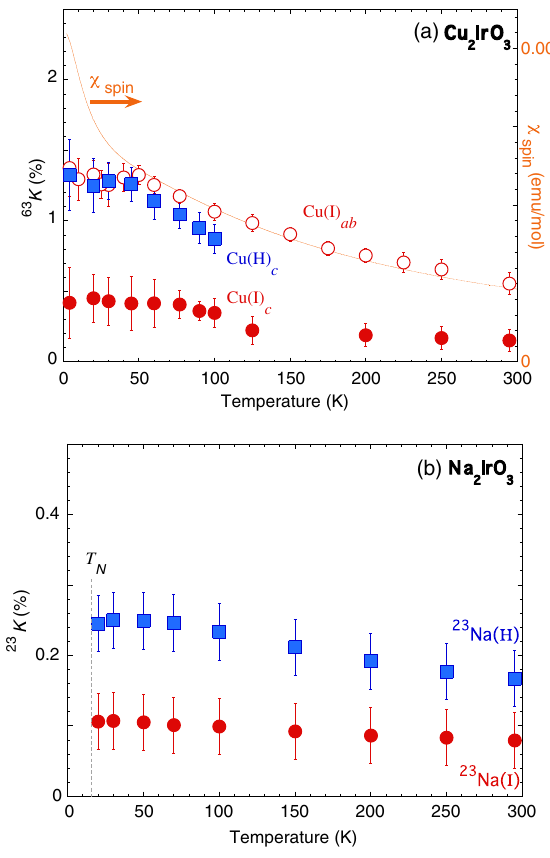
FIG. 11. (a) The temperature dependence of the intrinsic local spin susceptibility deduced as 63 K, in comparison to the bulk measured in 5 T (right axis). Notice averaged susceptibility χ spin that the large upturn observed below ∼ 30 K for the bulk χ data spin is absent in 63 K. (b) The temperature dependence of the intrinsic local spin susceptibility deduced as 23 K in Na 2 IrO 3 , as deter- mined from the NMR line shapes measured for a powder sample in Fig. 17.